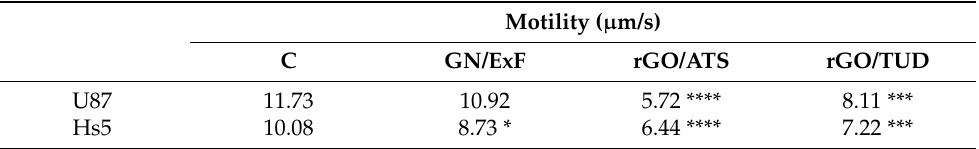
Table 2. Analysis of U87 and Hs5 cell motility in co-culture treated with graphene (GN) and reduced graphene oxide (rGO) expressed in µ m/s. Statistical significance between the control and the treated cells is indicated by an asterisk and was assessed using Bonferroni’s multiple comparisons test. Differences with p < 0.05 were considered statistically significant. One asterisk (*) indicates p < 0.05, three asterisk (***) indicates p < 0.001 and four asterisks (****) indicate p < 0.0001. Motility ( µ m/s) C GN/ExF rGO/ATS rGO/TUD U87 11.73